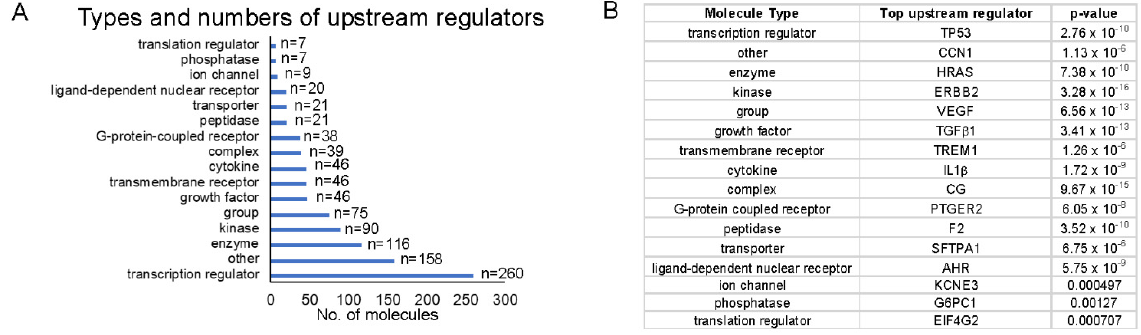
Figure 8. Top upstream regulators. ( A ) The number of each upstream regulator type is shown and ( B ) within each type of upstream regulator, we identified the most significant upstream regulator ( p -values shown). Upstream regulators were most frequently transcription regulators. The most significant transcription regulator and transmembrane receptor were TP53 and TREM1, respectively. expressed on myeloid cells 1 (TREM1) had 29 target molecules ( p = 1.26 × 10 − 6 ) (Figure 9A).